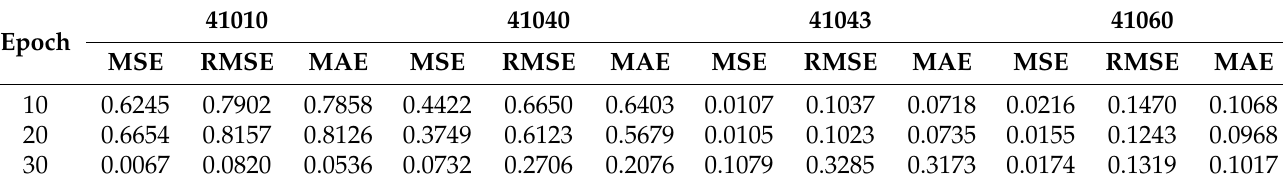
Table 9. Results of the original long short-term memory (LSTM) model in all